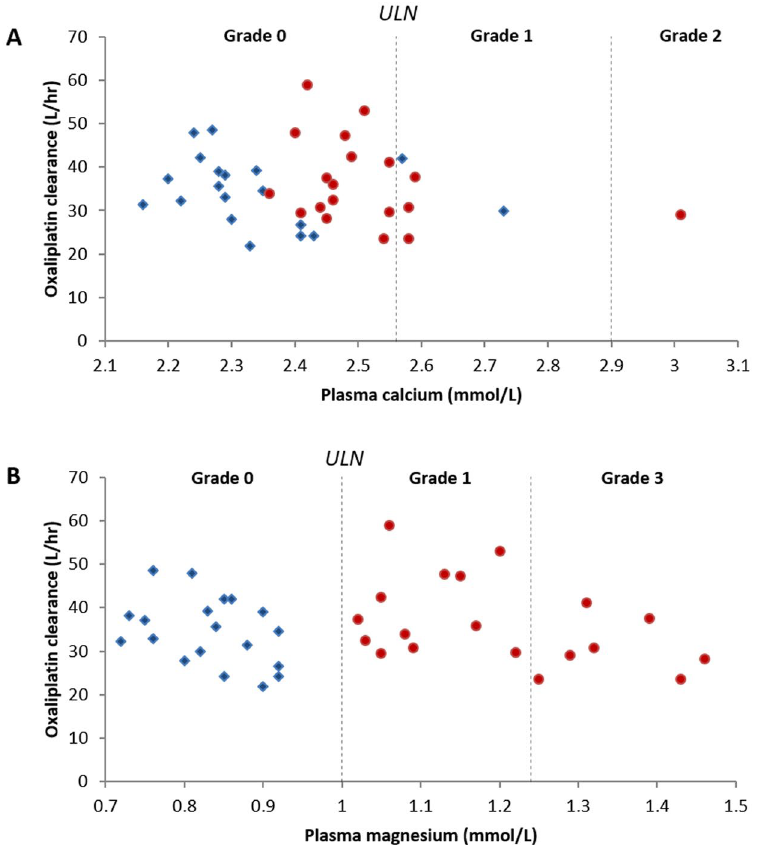
Figure 4. Correlation plots of oxaliplatin clearance versus plasma calcium ( A ) and magnesium ( B ) concentrations in colorectal cancer patients. Patients (n = 19) received CaGluc/MgSO 4 and placebo infusions on alternate cycles of oxaliplatin treatment in random order, during which oxaliplatin clearance and plasma calcium and magnesium levels were measured. Data points represent oxaliplatin clearance values and the maximal plasma calcium and magnesium concentrations achieved during the placebo (blue) and CaGluc/MgSO 4 infusion cycle (red) for each patient. Oxaliplatin clearance did not correlate with plasma calcium or magnesium concentrations (correlation coefficient = − 0.38; r 2 = 0.14; and p = 0.11). Vertical lines show Common Toxicity Criteria Adverse Event (CTCAE) severity gradings for hypercalcaemia and hypermagnesaemia. ULN: upper limit of